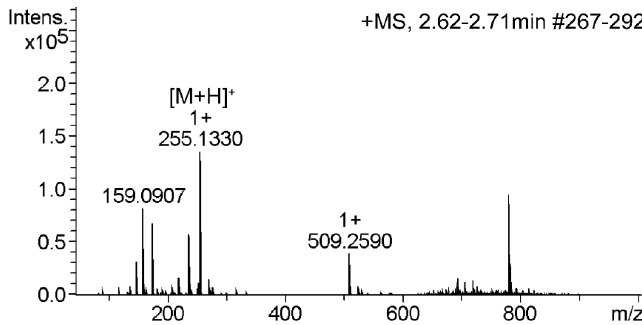
Figure 6. Product ion scan of pyrraline in a PED sample recorded by UPLC-UV-MS/MS (parent ion, m / z 255.1330).